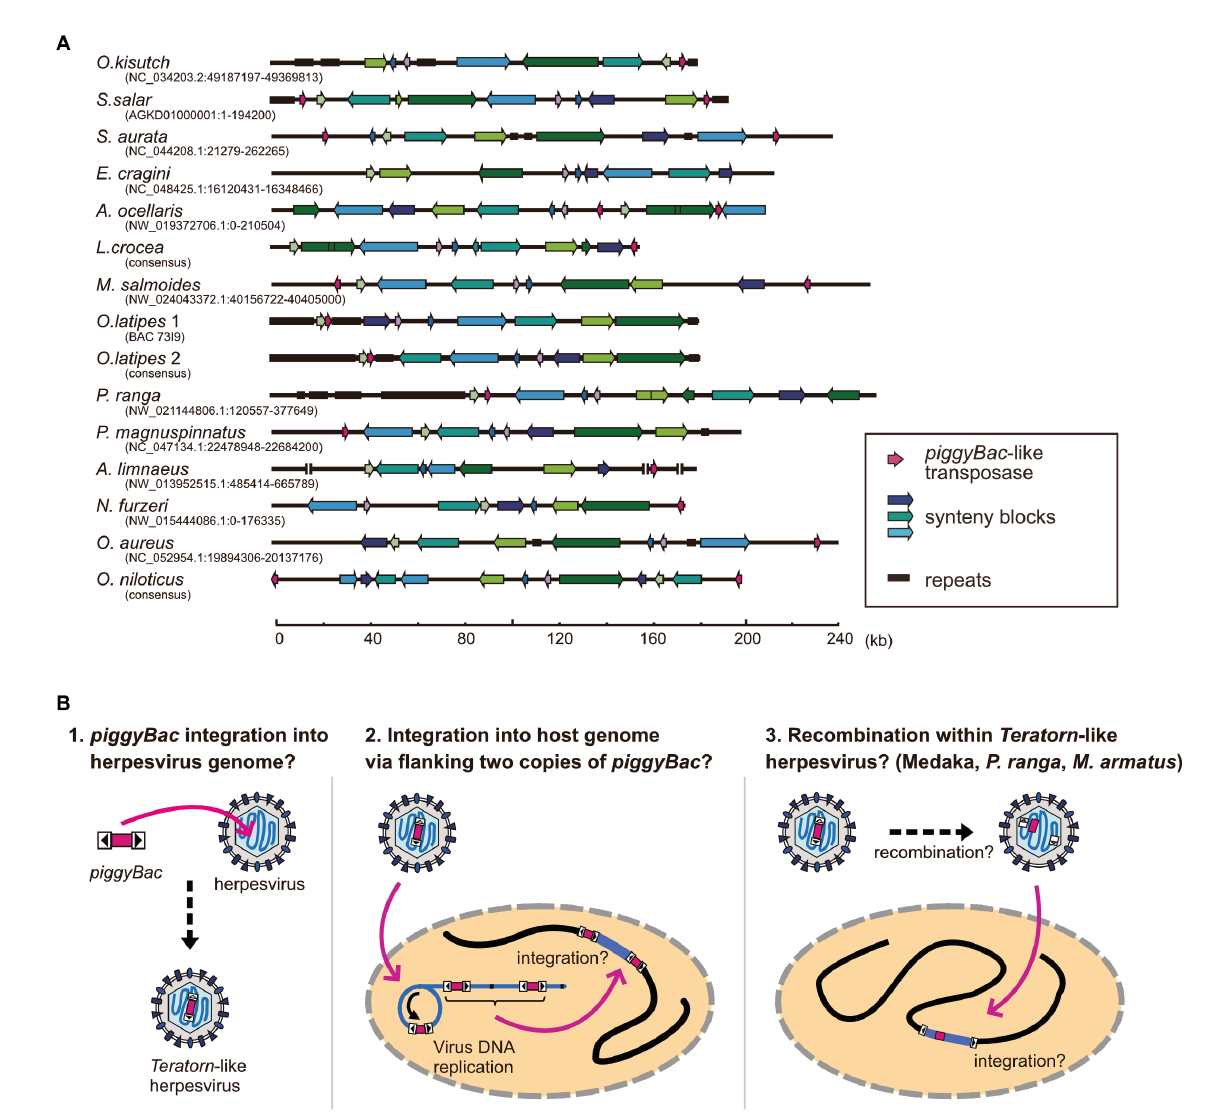
FIGURE 4 Structures of Teratorn -like herpesviruses and a model of the evolutionary process of piggyBac -herpesvirus fusion. (A) Structures of Teratorn -like herpesvirus in several teleost fish species. Conserved synteny blocks are depicted by the same colors. Magenta arrows indicate piggyBac -like transposase. (B) A model of the process of piggyBac -herpesvirus fusion. In this scenario, the initial event is the transposition of a piggyBac -like transposon into a herpesvirus genome (left). After formation of concatemeric virus DNA during replication, the internal herpesvirus genome was excised, with the two copies of piggyBac -like transposons as its boundary, and was integrated into the host genome (middle). A subgroup of Teratorn - like herpesviruses (those in medaka, M. albus, P. ranga , and M. armatus ) might have undergone further recombination, resulting in piggyBac transposase gene located in the middle while TIRs at both ends of Teratorn -like herpesvirus